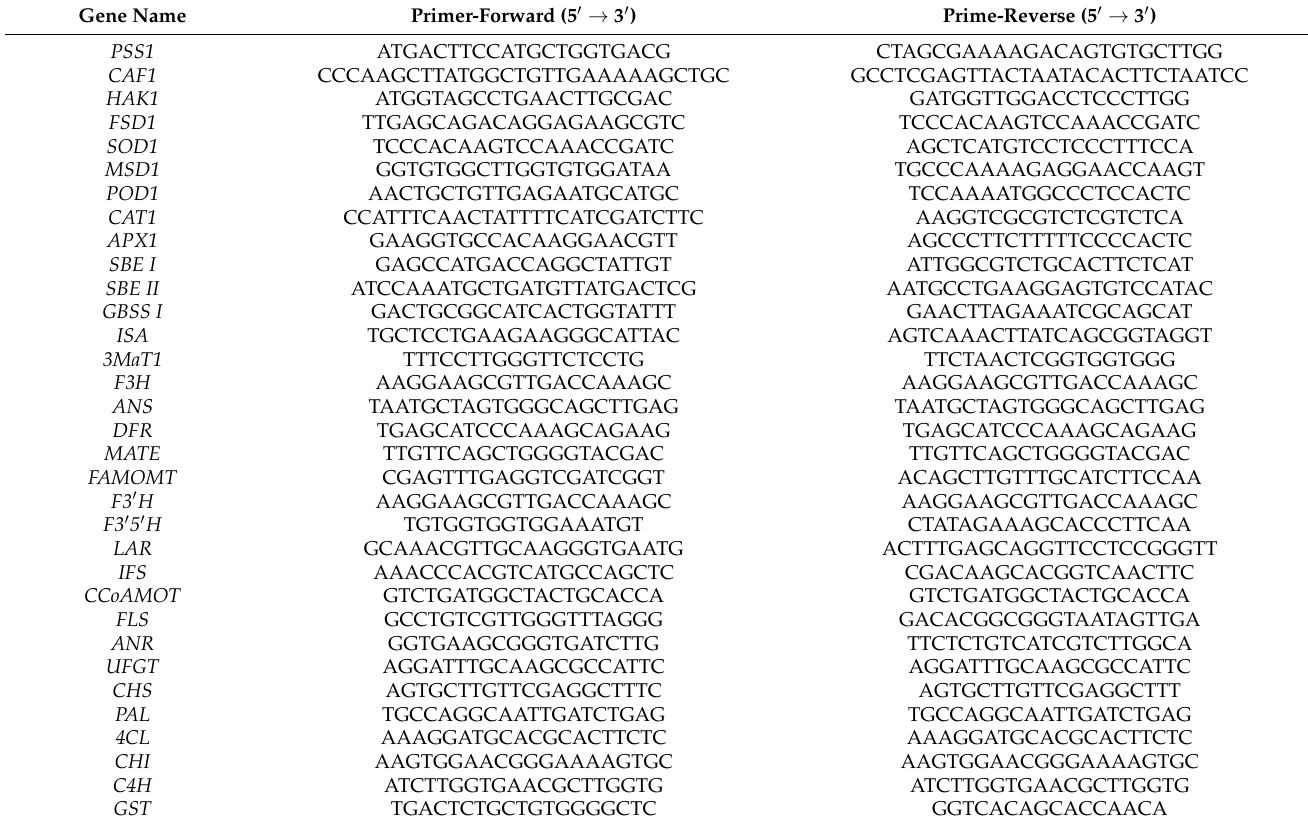
Table 1. Primers used for qRT-PCR and their accession